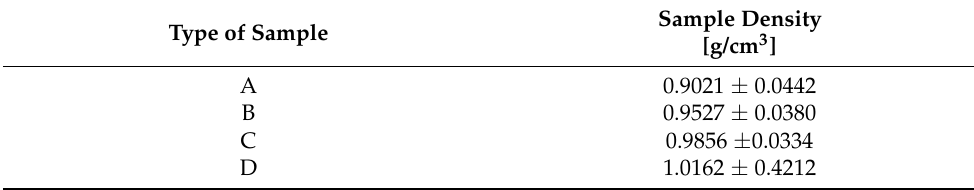
Table 3. Density of the tested samples.